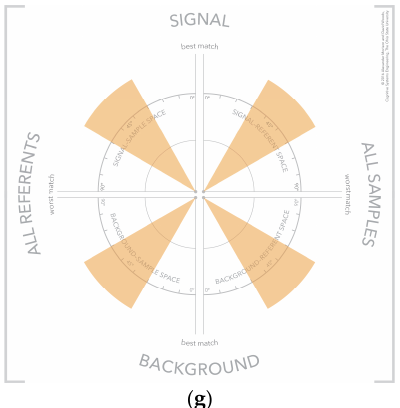
Figure 11. The visual patterns that indicate different types of samples including: ( a ) strong signal; ( b ) strong background; ( c ) weak signal; ( d ) weak background; ( e ) unknown sample; ( f ) strong confusor; and ( g ) ambiguous.